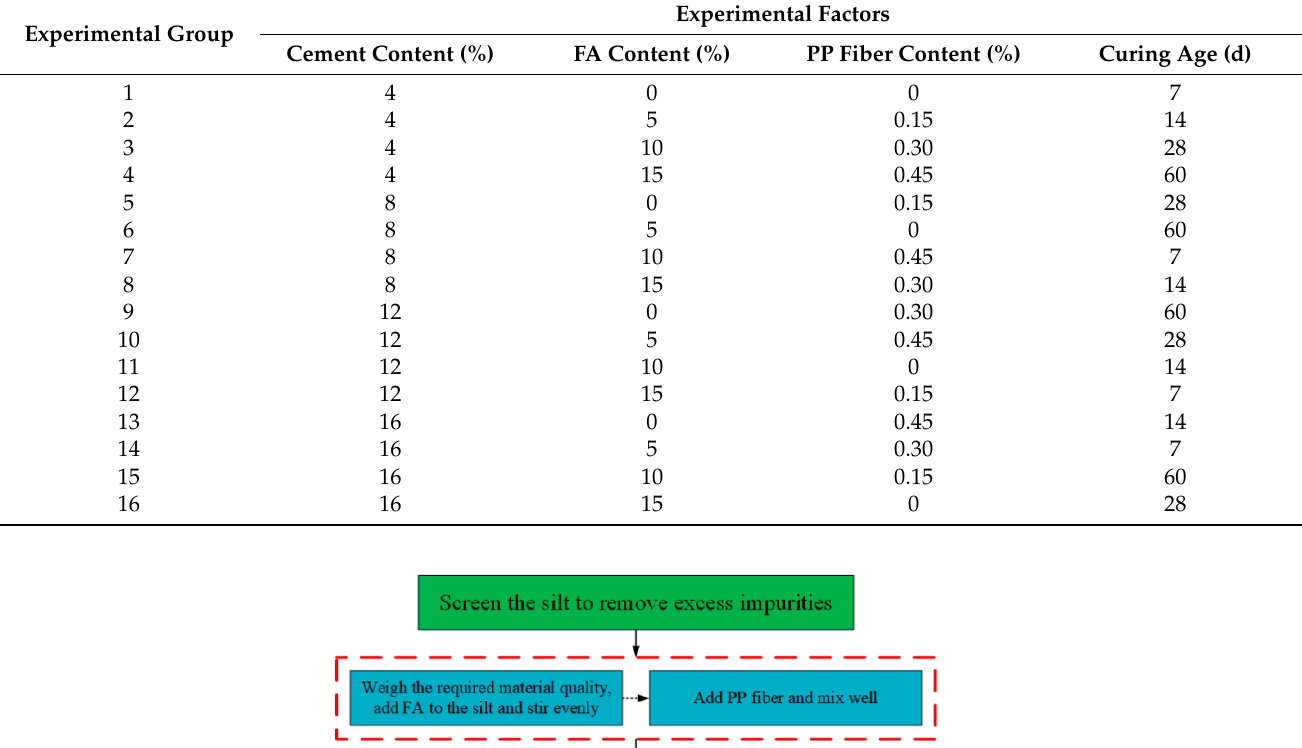
Experimental Group